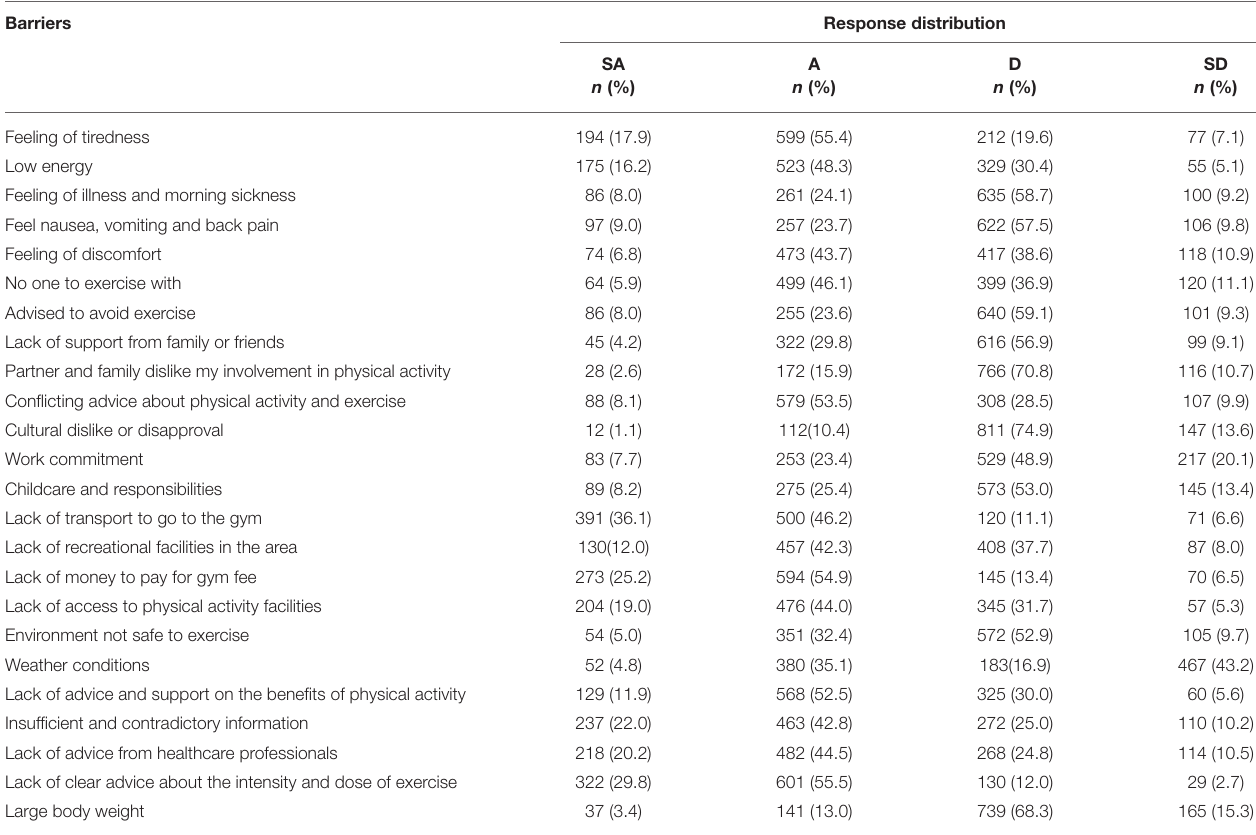
TABLE 1 | Barriers to physical activity and exercise ( n =